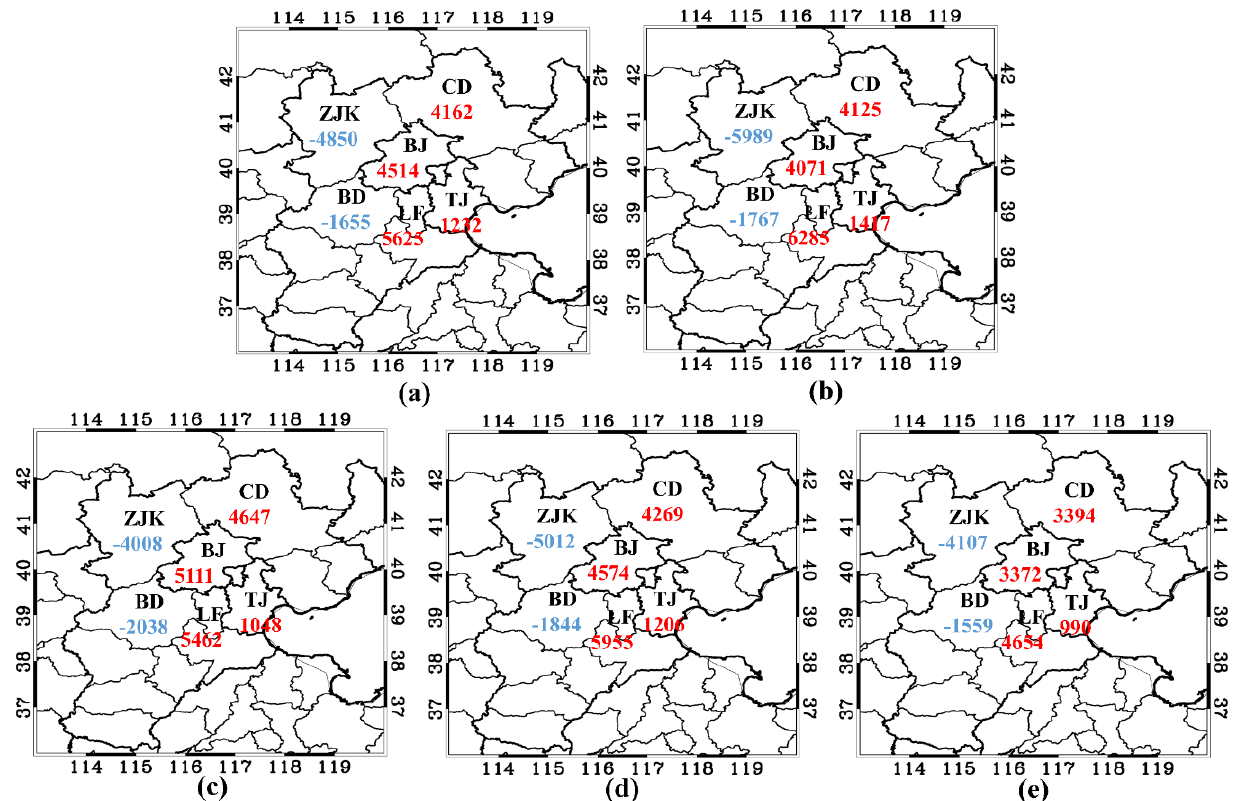
Figure 6. Four-month averaged tropospheric NOx transport fluxes across city boundary for BJ. ( a ) Calculated NO 2 flux in W_2018 with MEIC-2017 inventory. ( b ) Same as ( a ) except with top-down W_2018 inventory. ( c ) Calculated NO 2 flux in W_2019 with MEIC-2017 inventory. ( d ) Same as ( c ) except with top-down W_2018 inventory. ( e ) Same as ( c ) except with top-down W_2019 inventory. Red number means net flux is inflow the NOx. Blue number means net flux is outflow NOx. Unit of flux is g/s.